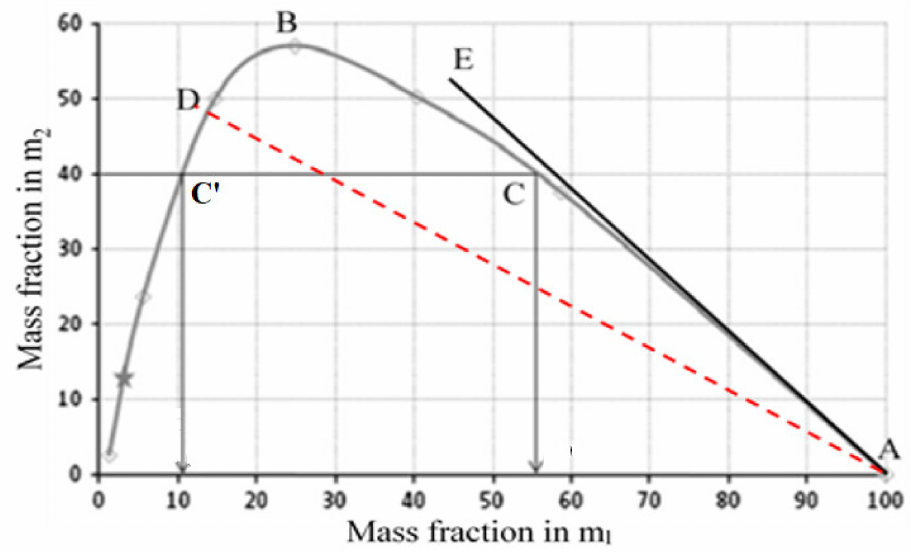
Figure 5. The plot of m 1 versus m 2 for silica sand for size 600 µ m during the batch milling process [9]. At point C, 45% of the feed material has been broken into m 2 and m 3 , which then comprise 40% and 5% in the product stream, respectively. In the curve is also shown point C (cid:48) which has the same concentration of 40% of m 2 when 90% of m 1 is milled. The amount of m 1 which remains in the system at C is 55% and m 3 is (100 − m 1 − m 2 ) = 5% whereas